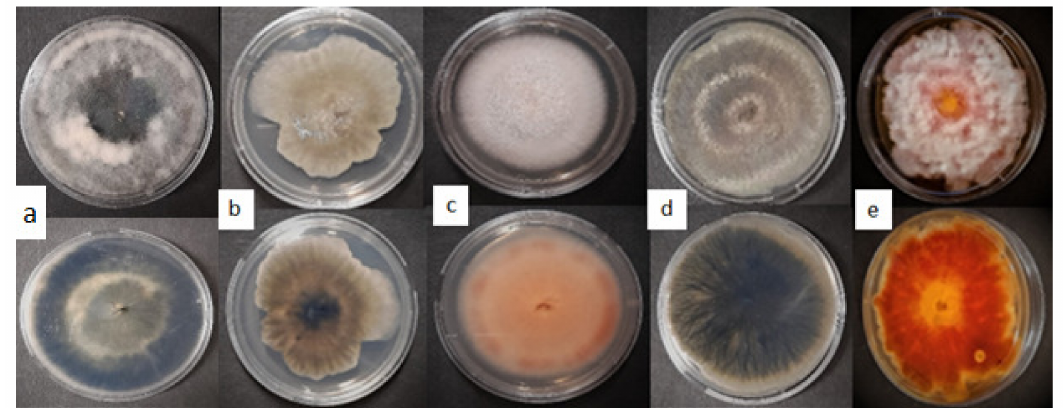
Figure 4. Front and back view of the fungal isolates ( a ) Bioplaris zeicola, ( b ) Phoma herbarum, ( c ) Epicoccum nigrum, ( d ) Alternaria alternata, ( e ) Fusarium brachygibbosum. Sequences of the isolated fungal strains were aligned with those earlier documented on the NCBI platform. The phylogenetic relationship tree of the isolates revealed AD6 clustered into a distinct, well-supported clade with Phoma herbarum MT420621, AH1 clustered with Epicoccum nigrum MT582797, BD2 with Fusarium brachygibbosum KY024400, and BD5A with Alternaria alternata MN249500, while AD1 clustered with a clade supported by Bipolaris zeicola MT841439 (Figure 5).